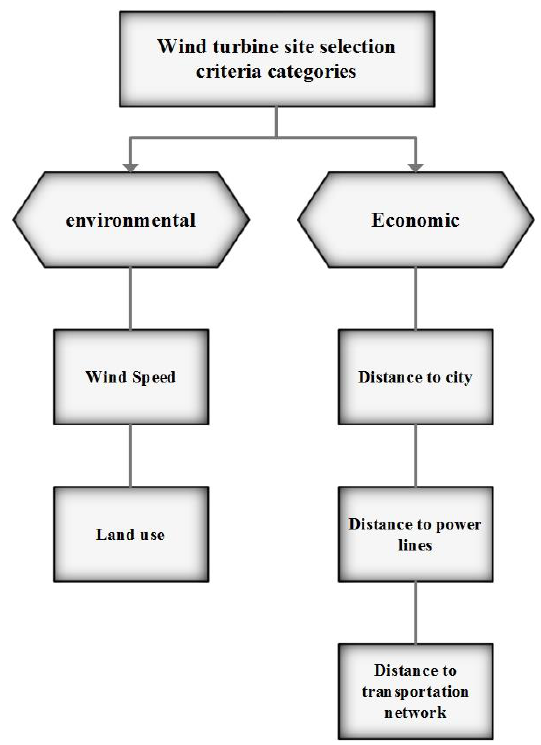
Figure 3. Criteria and factors for wind turbine site selection